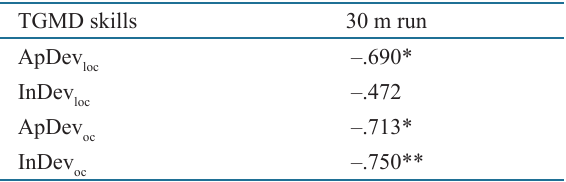
Correlation coefficients (r) between the level of funda- mental motor skills and 30 m run test outcomes